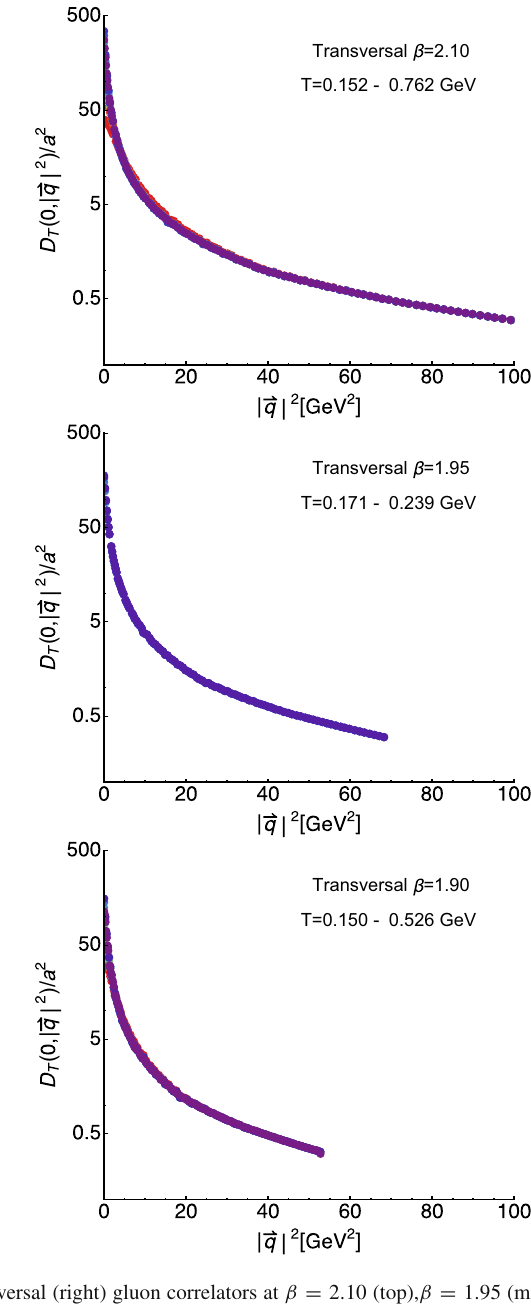
= 0 but finite spatial momenta | q | 2 for different temperatures 4